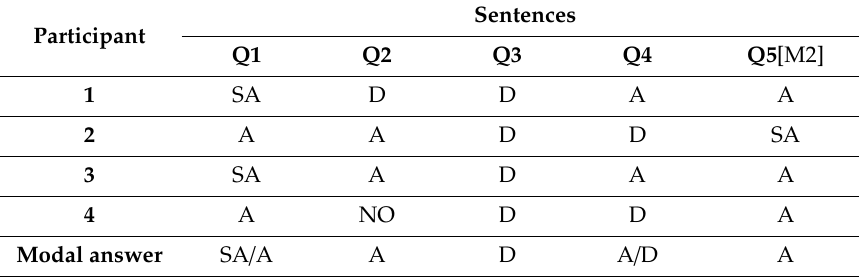
Table 6. Answers (strongly agree (SA), agree (A), no opinion (NO), disagree (D), and strongly disagree (SD)) of each participant from the experimental group and modal answers of the group regarding usability questionnaire ((Q1) “I think that I can walk more compliantly with the exoskeleton after using the BS”; (Q2) “I need more time to learn how the BS works before I can get going with it”; (Q3) “I need to learn other things before I can get going with the BS”; (Q4) “I imagine that most people will learn to use the BS very quickly”; and (Q5) “After understanding how the BS works, I think that I need the support of a physiotherapist along with gait